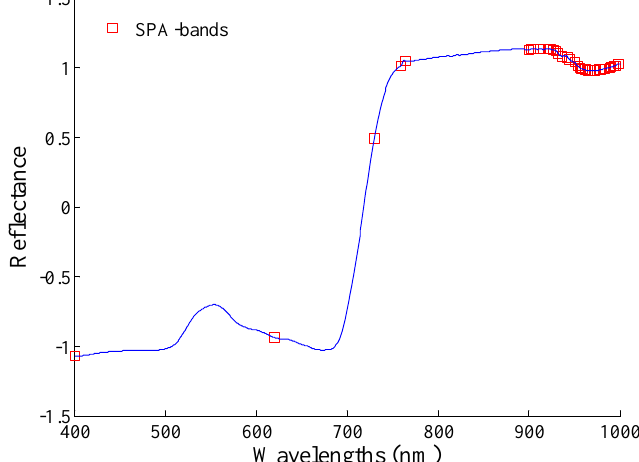
Figure 6. Growth stage-sensitive wavelengths selection result of potato using the successive projection algorithm (SPA).